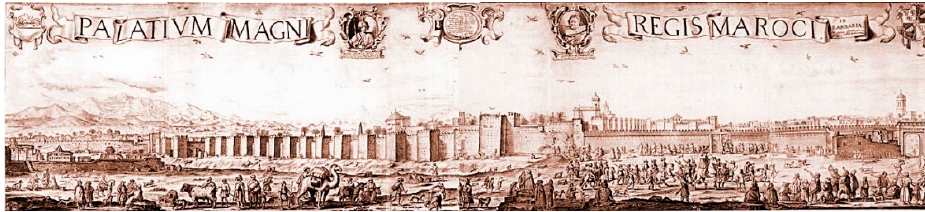
Figure 8. The Medina of Marrakesh in the Medieval period (data source: A drawing of the Badi palace in its heyday, by Adriaen Matham, 1640: https://landscapelover.wordpress.com (accessed on 20 December 2019)).